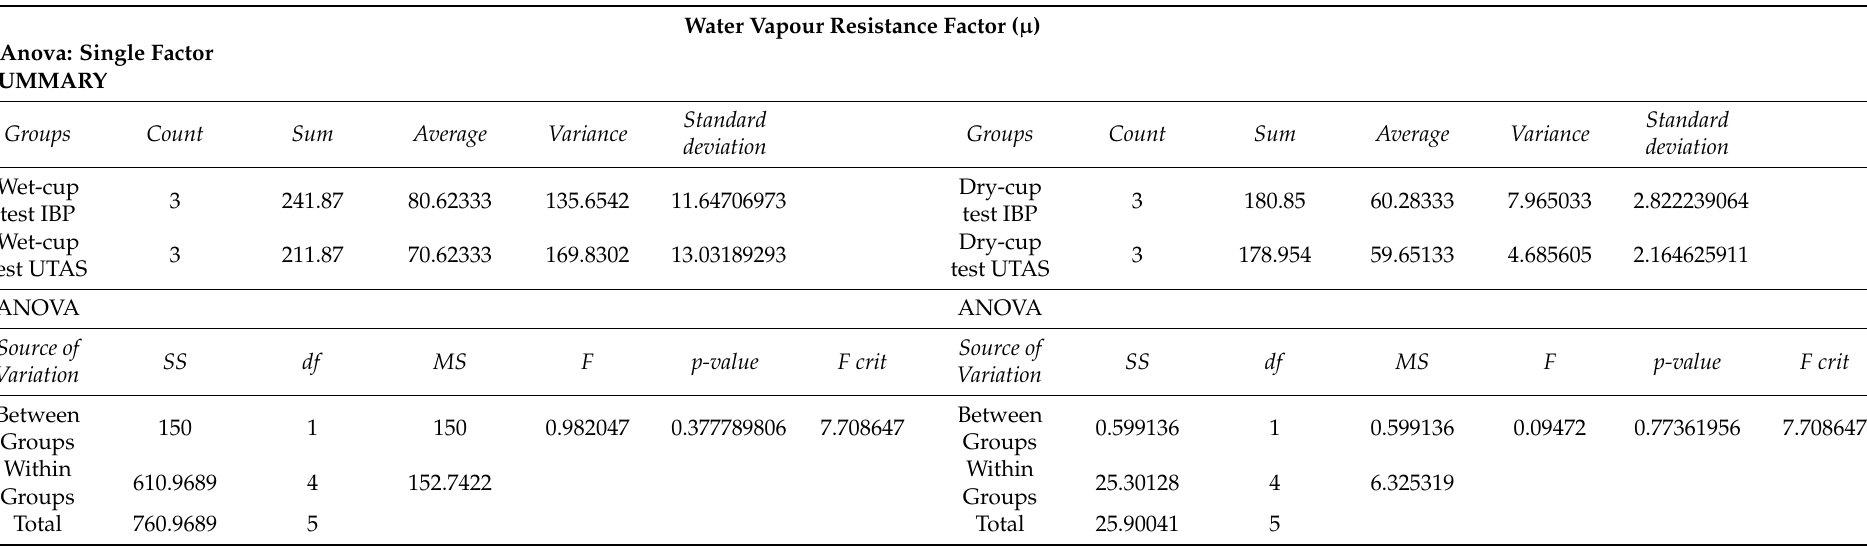
Table 5. Inter-laboratory comparison of the ANOVA result for the resistance factor ( µ ) of wet-cup